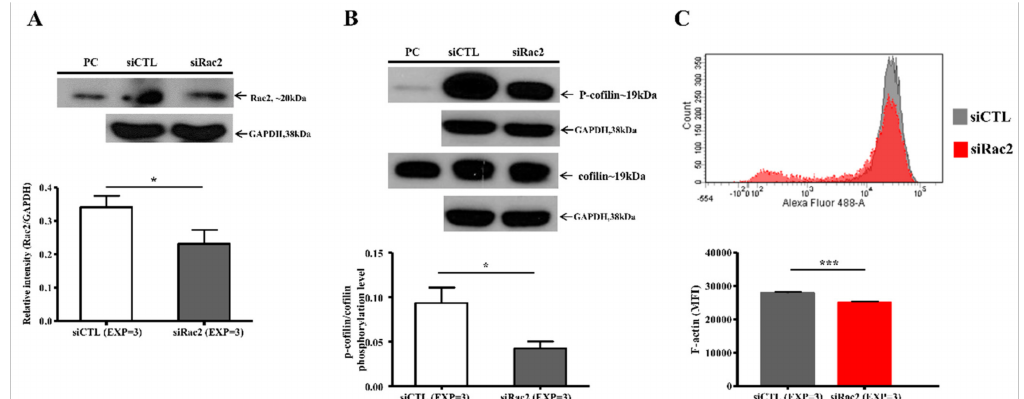
Figure 7. The expression of the Rac2, ratio of p-cofilin/cofilin and F-actin in the rat ventricular cardiomyocytes after silencing Rac2 gene. After silencing Rac2, the expression of Rac2 protein in the rat ventricular cardiomyocytes was significantly decreased compared to the control group (siCTL) without silencing Rac2 by immunoblotting study ( A ). The ratio of p-cofilin/cofilin in the rat ventricular cardiomyocytes was significantly lower in the siRac2 rat ventricular cardiomyocytes than the siCTL group ( B ). Flow cytometric study showed the mean fluorescence intensity (MFI) of F-actin was significantly lower in the siRac2 rat ventricular cardiomyocytes compared to the siCTL group ( C ). *: p < 0.05 and ***: p < 0.001. PC: positive control.